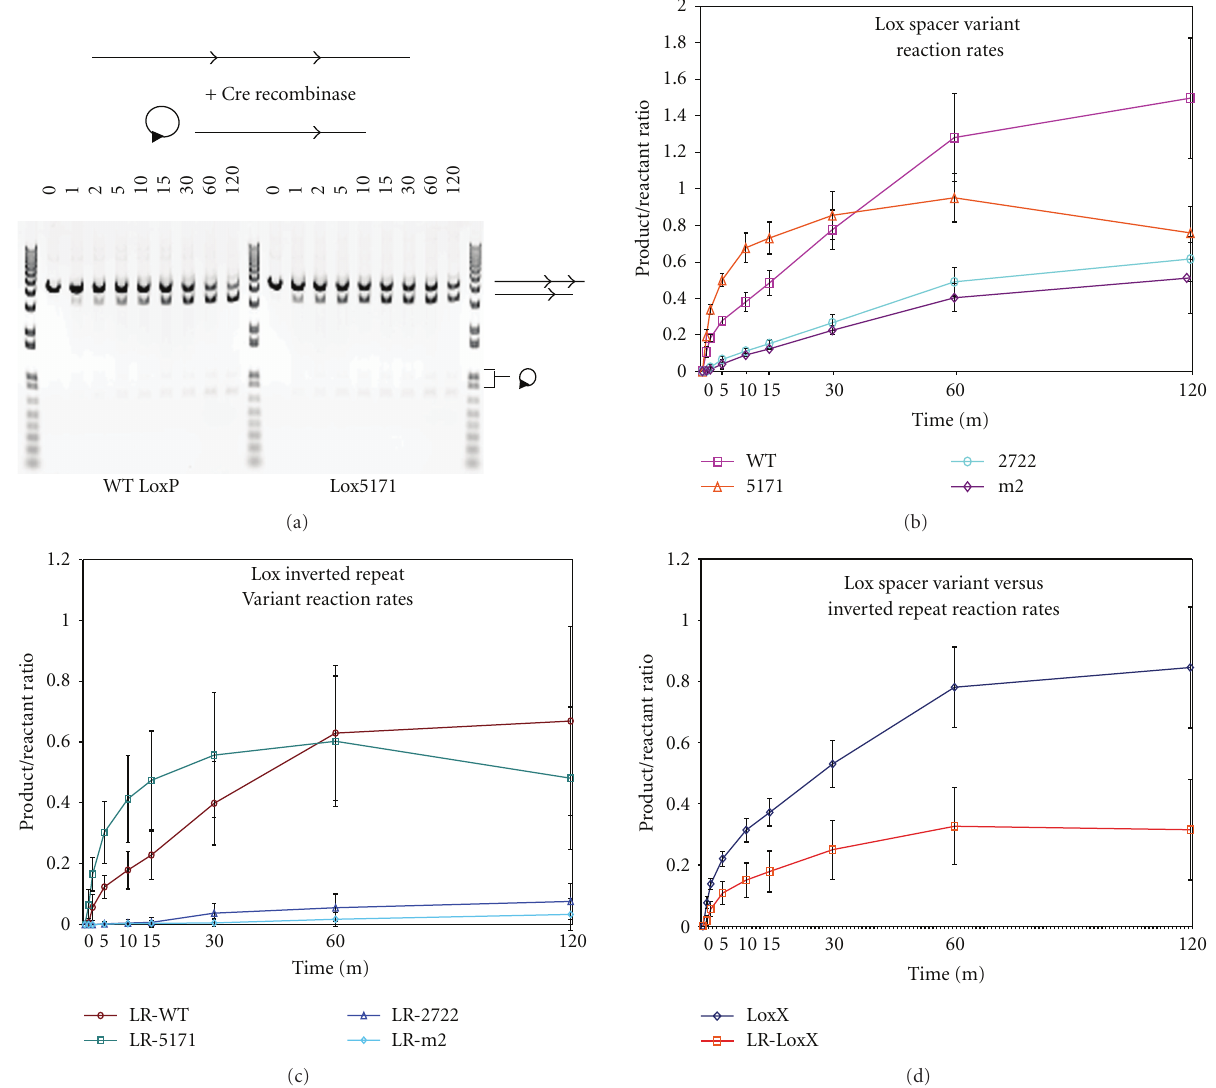
Figure 2: Comparison of reaction rates of Lox variant sites. (a) Fragment bearing Lox sites used as reactant on top with products resulting from Cre-mediated excision of reactant below. Shown on the bottom is gel electrophoresis to separate Cre-mediated reaction fragments. Time in minutes indicated at top of each lane. Identity of Lox variant is denoted below each time course. Identity of bands denoted at right of gel. (b)–(d) Reaction progress plotted as the ratio of products/reactants +/ − SEM. (b) LoxP in magenta, Lox5171 in orange, Lox2722 in blue, and Loxm2 in purple. (c) LR-LoxP (LoxP-66-LoxP-71) pair in maroon, LR-Lox5171 in teal, LR-Lox2722 in blue, and LR-Loxm2 in light blue. (d) Average of all Lox spacer variants with (orange) or without (blue) inverted repeat